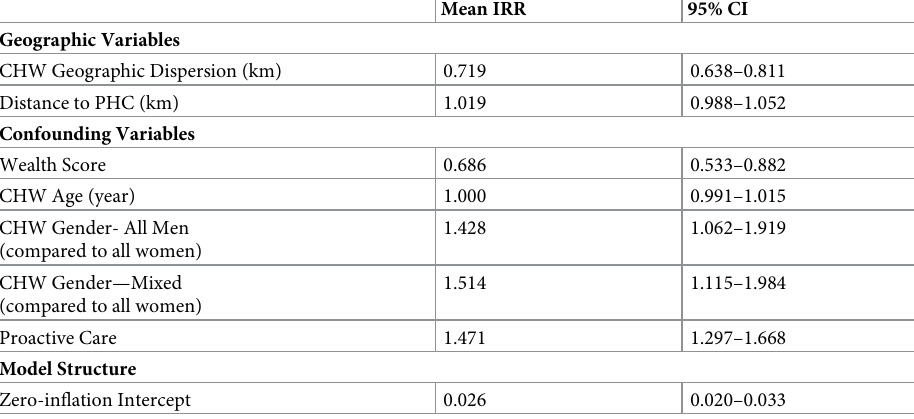
Table 2. Results of statistical model estimating effects of geographic barriers on CHW consultation rates. Inci- dence rate ratios (IRR) of variables included in the model. Following Wasserstein et al. [48], we have chosen to provide 95% confidence intervals and not to dichotomize these continuous measures into thresholds of significance (e.g. p-val- ues). CHW: community health worker, PHC: primary health